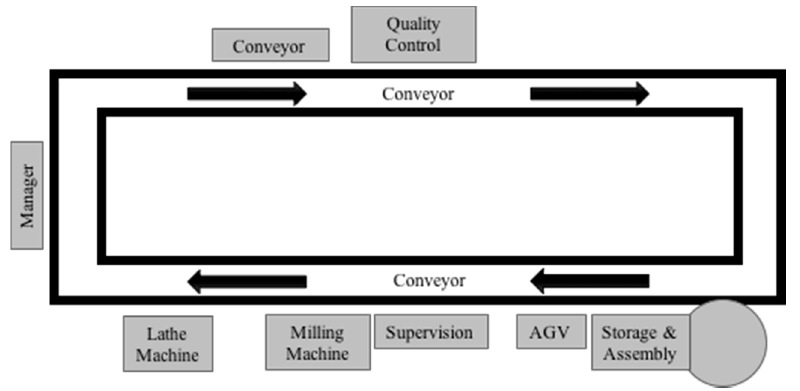
Figure 3. Manufacturing cell plant.